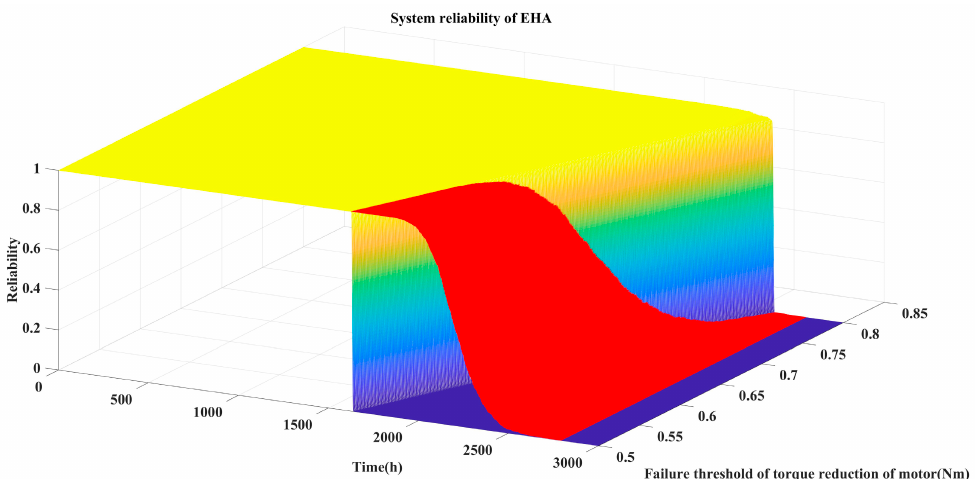
Figure 11. Failure related energy dissipation (FED) distribution with di ff erent individual failure thresholds.